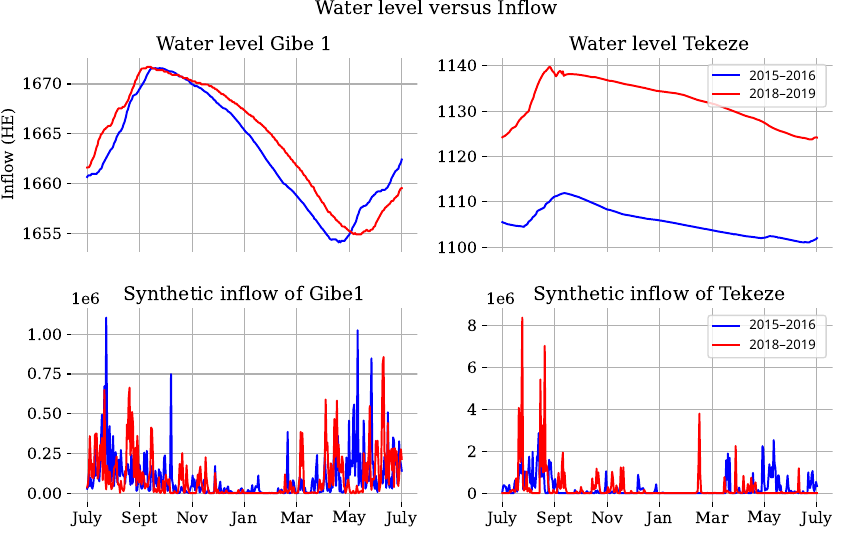
Figure 8. Actual water level versus synthetic inflow in 2015–2016 and 2018–2019 for Gibe 1 and Tekezé